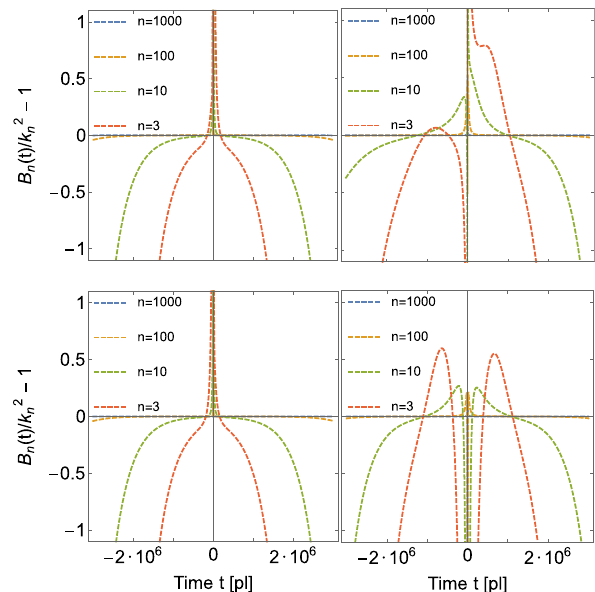
Fig. 4 Behaviour of the functions B n ( t ) around the bounce t = 0, for different wave numbers n and initial conditions, in the case of a Starobinsky potential. top left: evolution from the IC {− 0 . 99 , + 1 } , top right: {− 0 . 5 , + 1 } , bottom left: {− 0 . 99 , − 1 } , bottom right: {− 0 . 5 , − 1